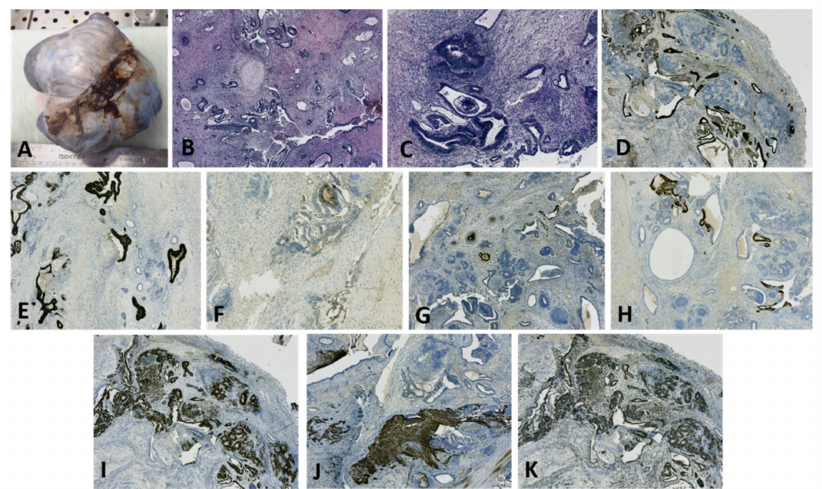
Figure 11. Polycystic right ovarian tumor with composite areas, microscopically diagnosed as malig- nant mixed germinal cell tumor (embryonal carcinoma, immature teratoma with neuroectodermal differentiation, and minor yolk sac component) in a 33-year-old patient: ( A ) Macroscopic appearance of a large ovarian mass; ( B ) Mixed histopathological pattern malignancy consisting of predominantly irregular, angulated glandular structures, rare Schiller-Duval bodies, and atypical glial tissue (HE, × 25 magnification); ( C ) Composite tumor including irregular, angulated glandular structures, and immature teratoma with neuroectodermal tubules (HE, × 50 magnification); ( D ) AE1/AE3 immunore- activity in epithelial cells; no reaction in neuroectodermal tubules ( × 25 magnification); ( E ) CD30 immunoreactivity in epithelial cells; no reaction in neuroectodermal tubules and yolk sac elements ( × 25 magnification); ( F ) Glypican-3 immunoreactivity in yolk sac elements ( × 50 magnification); ( G ) AFP immunoreactivity in yolk sac elements ( × 25 magnification); ( H ) OCT4 immunoreactivity in embryonal carcinoma elements ( × 25 magnification); ( I ) Sall4 immunoreactivity in neuroectodermal tubules and rosettes ( × 25 magnification); ( J ) GFAP immunoreactivity in immature neuroectodermal structures ( × 25 magnification); ( K ) high proliferation index (Ki67, × 25 magnification). (Courtesy